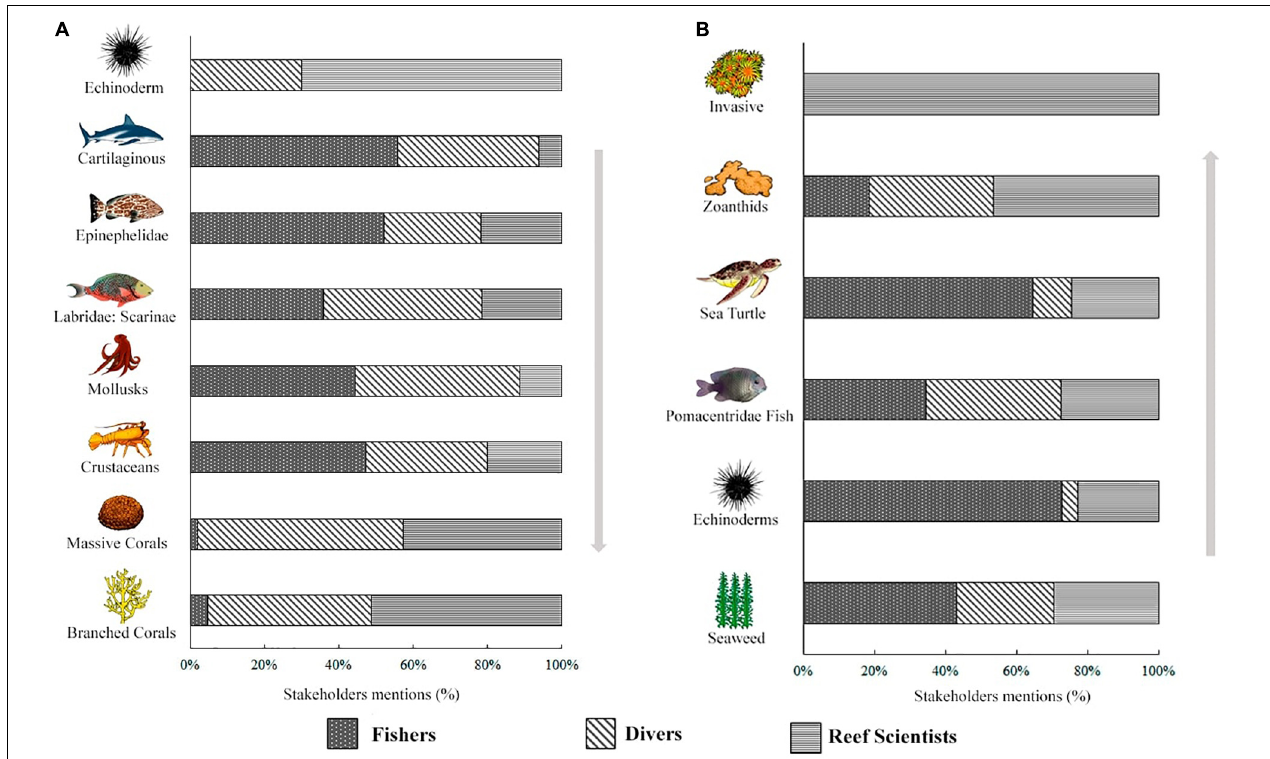
FIGURE 2 | Main organisms mentioned by fishers, divers, and reef scientists as having decreased (A) or increased (B) in the Brazilian reef landscapes in the last six decades. Only organisms that had a minimum of 5% in each group of citations were included among the total citations of increase and decrease, respectively. The down arrow on the left represents the organisms that declined, and the up arrow on the right represents the organisms that increased in reef